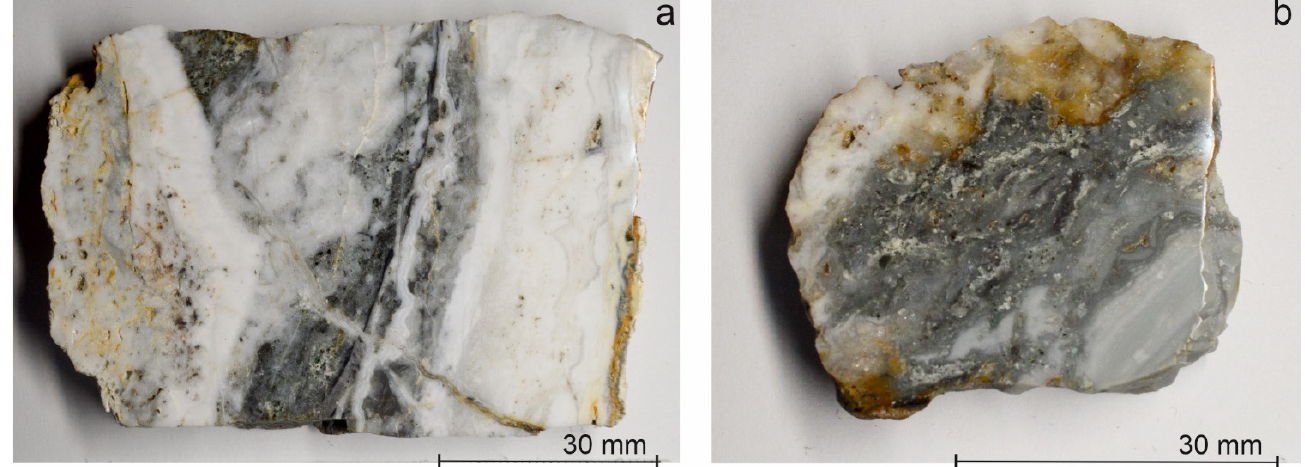
Figure 3. Sample of sericite-adularia-quartz composition with crustified-breccia texture containing disseminated sulfide: sample from adit 1 ( a ), sample from adit 2 ( b ).